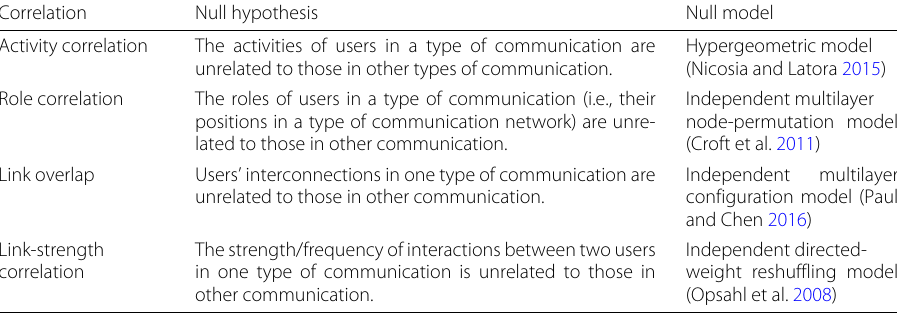
Table 2 Null hypotheses on correlations of individuals’ activities and roles in types of communication Correlation Null hypothesis Null model Activity